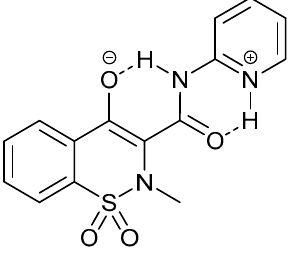
Figure 20. Zwitter ionic form of piroxicam.